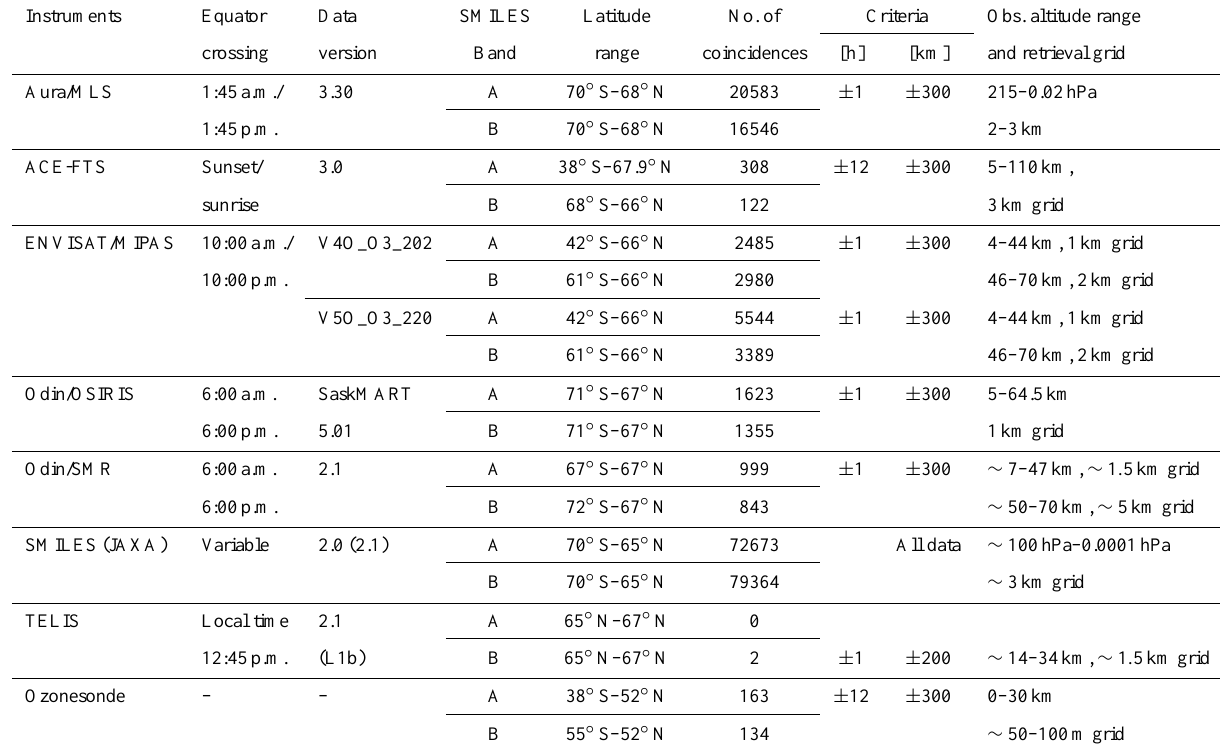
Table 4. Summary of the comparison datasets and the coincidences criteria applied in this study. Local time of the equator crossing is shown for satellites with a sun-synchronous